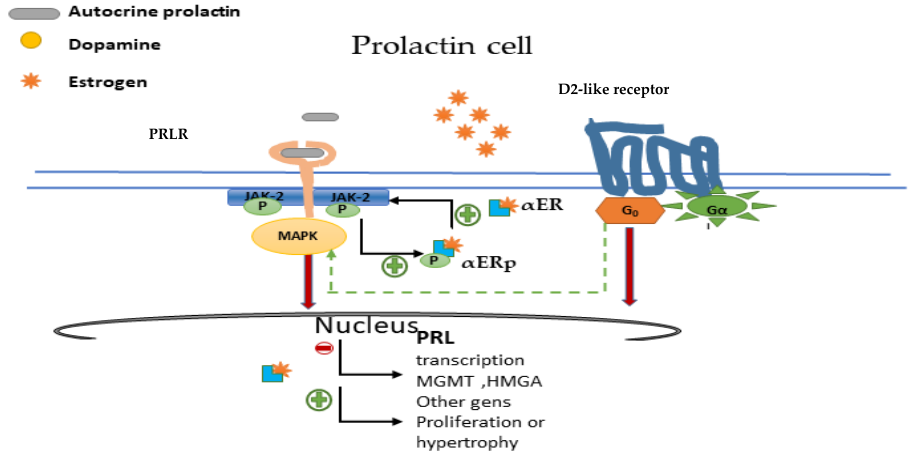
Figure 5. Nuclear oestrogen receptor ( α ER) and crosstalk with PRLR and D2R. Oestrogens bind to α ER, which stimulates lactotroph cell growth and proliferation. Prolactin induces phosphorylation of α ER ( α ERp), while oestrogen promotes PRLR upregulation via pER α . ER α inhibition, restores pituitary adenoma cell sensitivity to bromocriptine by activating among others D2-G0 MAPK signalling. PRLR: prolactin receptor; D2R: dopamine receptor; α ERp: phosphorylated α ER.